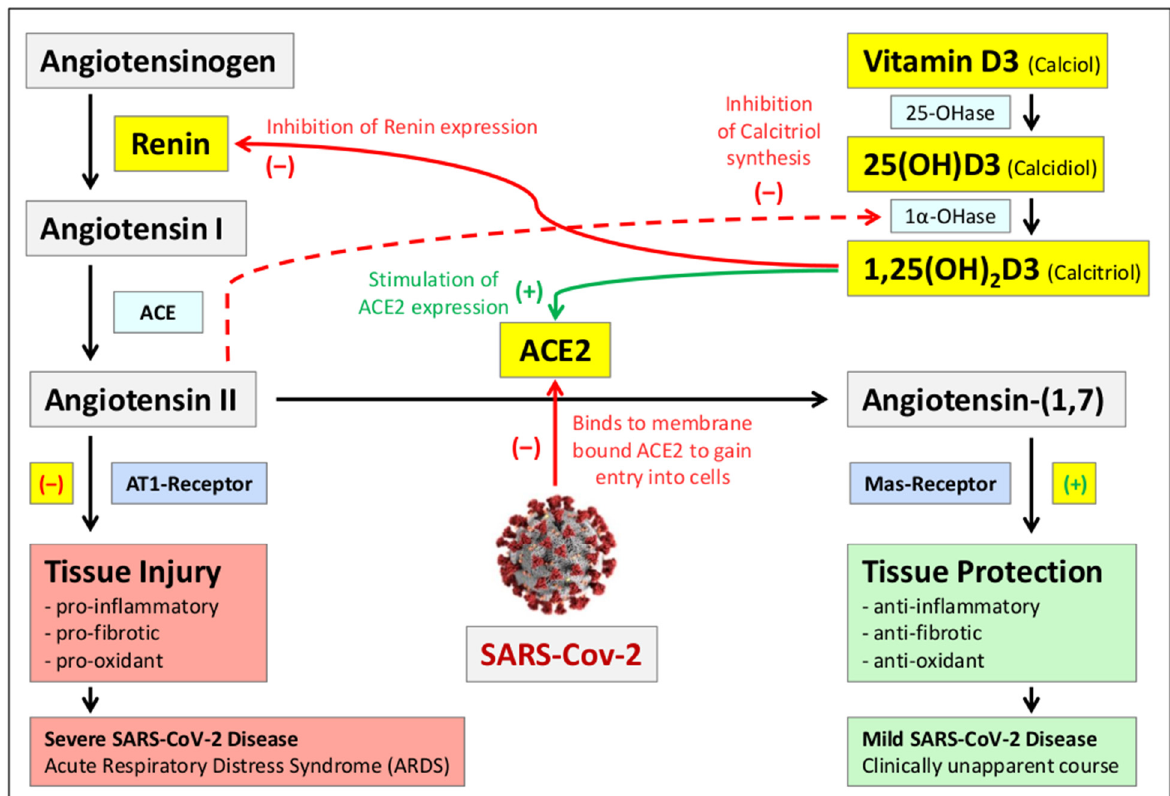
Figure 2. Interaction of vitamin D3 with the renin-angiotensin system (RAS): The renin-angiotensin system (RAS) is an important regulator of blood volume and systemic vascular resistance for the adjustment of blood pressure. The balance between angiotensin II and angiotensin-(1,7) is a critical factor for the proper functioning of the system [87]. Angiotensin- converting enzyme 2 (ACE2) is responsible for converting angiotensin II to angiotensin-(1,7). Angiotensin II primarily triggers vasoconstriction but can also cause inflammation, fibrosis, and oxidative stress in the absence of its counterpart, angiotensin-(1,7). ACE2 is the primary receptor of SARS-CoV-2, which decreases its activity, leading to an increase in angiotensin II levels and a decrease in angiotensin-(1,7) levels. This effect ultimately triggers SARS-CoV-2-induced “acute respiratory distress syndrome” (ARDS) [85,86]. Calcitriol, the active metabolite of vitamin D3, minimizes this effect by inhibiting renin expression and thus angiotensin II synthesis and by stimulating ACE2 expression [88,89], enhancing the conversion of angiotensin II to angiotensin-(1,7). Thus, insufficient vitamin D blood levels lead to the development of severe courses of SARS-CoV-2 disease. In addition, it has been shown that high angiotensin II levels lead to downregulation of the enzyme 1-alpha-hydroxylase [93], which is required for the formation of calcitriol, thereby exacerbating the negative consequences of vitamin D deficiency.